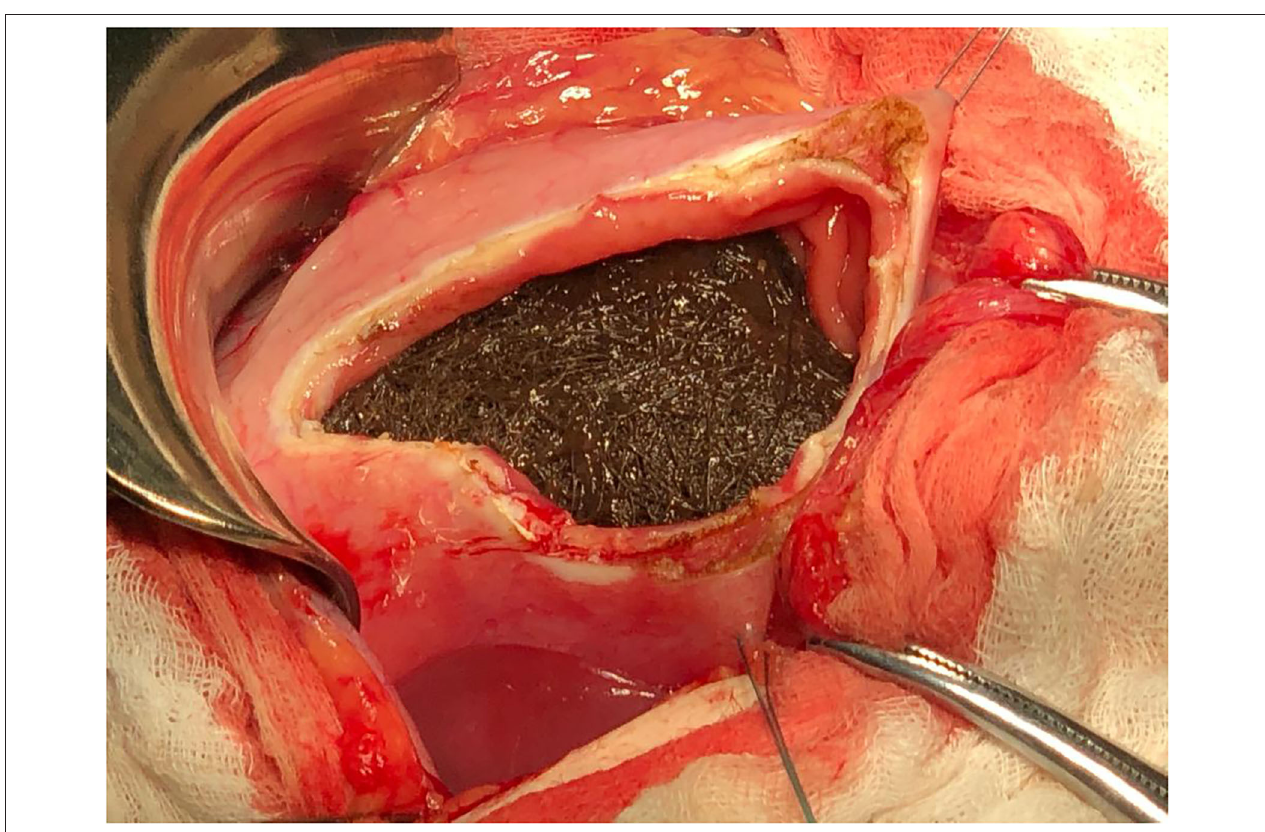
FIGURE 3 | Intraoperator aspect of